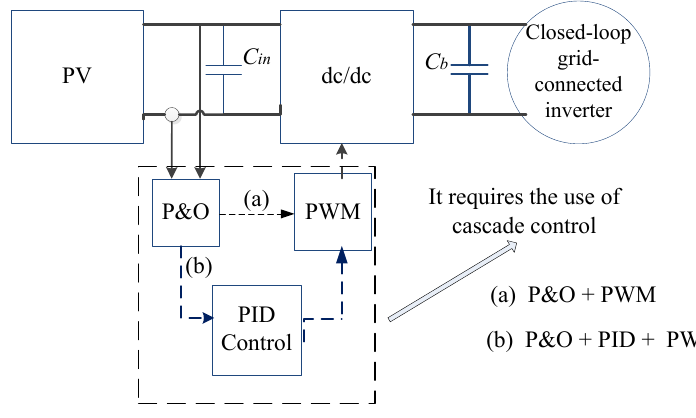
Figure 18. Structure of a conventional Maximum Power Point Tracking (MPPT) architecture.